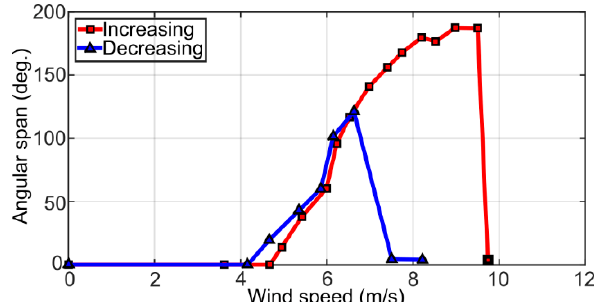
Figure 8. Representative hysteresis cycle for the full-solar flag.